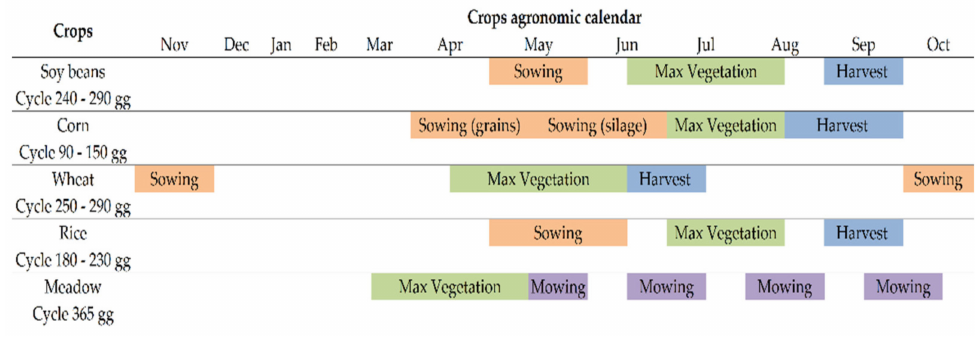
Figure 2. Crop agronomic calendars where the main agronomic phases of crop growing are reported. Table 1. Sentinel-2 MSI technical features and SCL code pixel